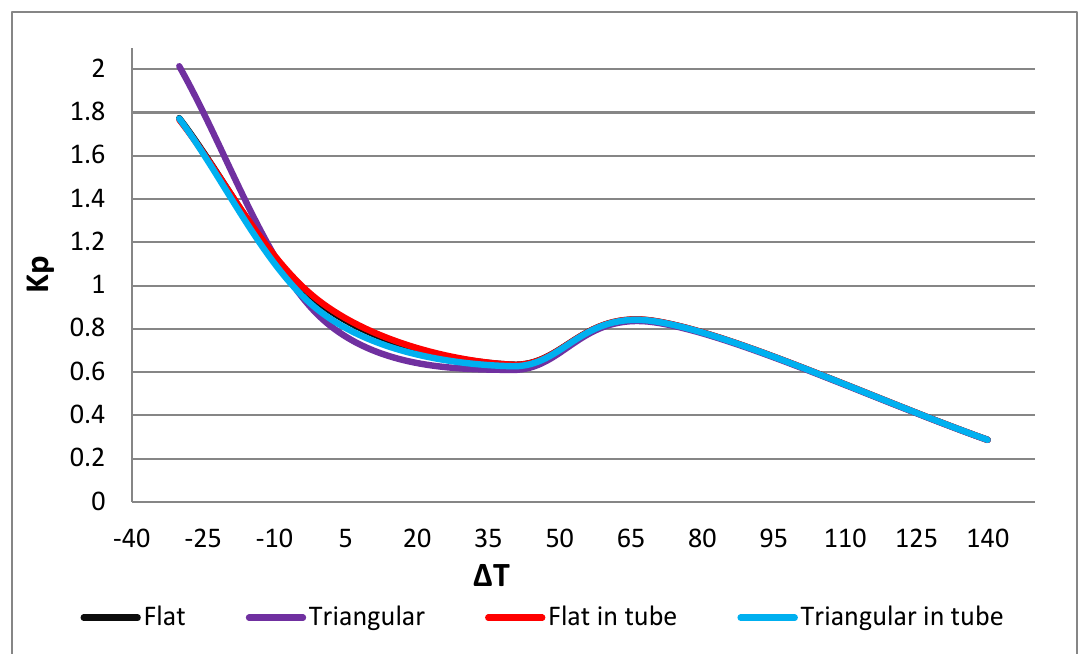
Figure 12. Correction factor value that takes into account the temperature difference between the cable core and the external environment for different cable